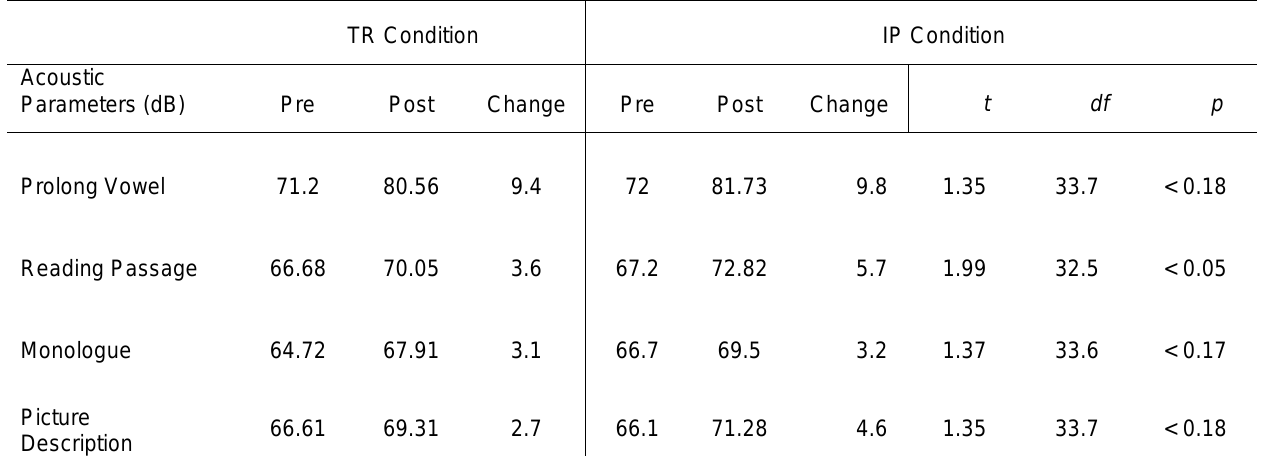
Table 5. Comparison of Results for Each